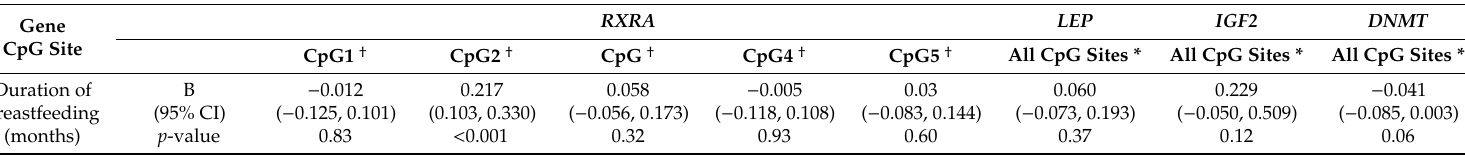
Table 5. Association between breastfeeding (months) and gene-specific buccal DNA methylation in one-year-old children. CI—confidence